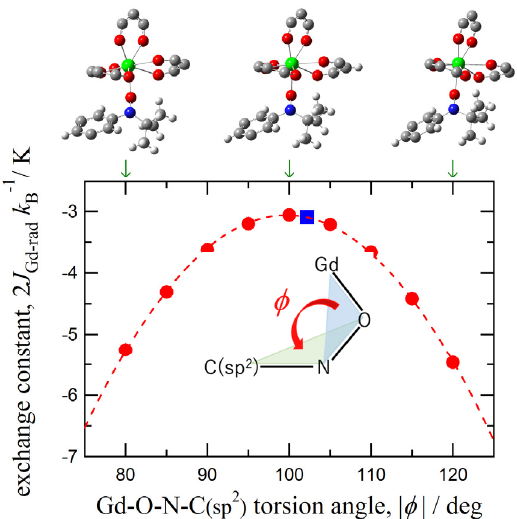
Figure 6. Computational magneto-structure relation by varying φ in 2 . Three model structures are drawn, where selected atoms are shown for clarity. For atomic color code, see Figure 5. A square symbol stands for the experimental structure. A broken line is drawn for a guide to the eye. Inset shows a schematic drawing of the definition of φ .